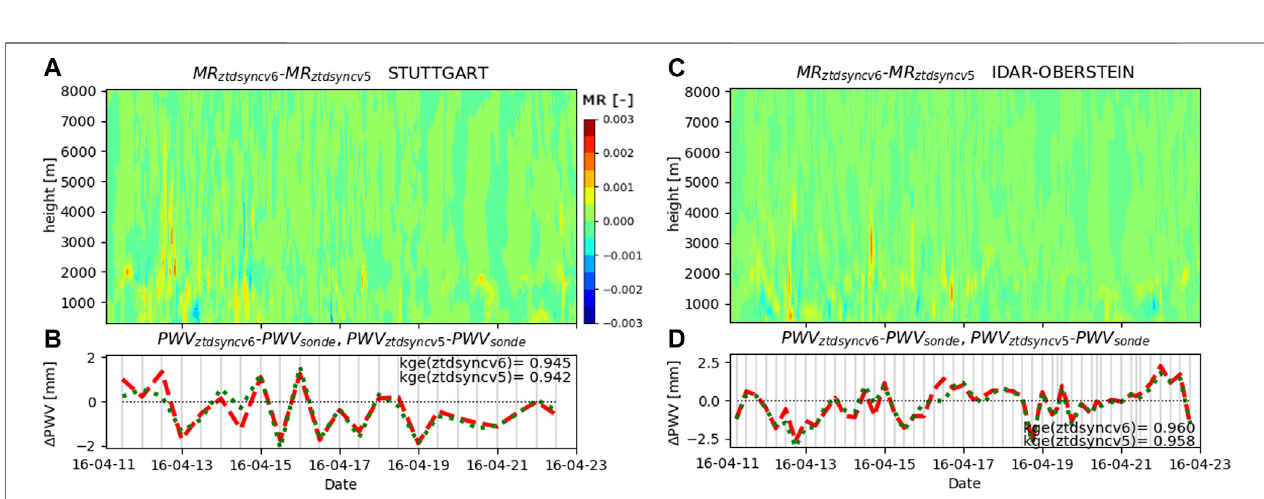
Frontiers in Earth Science |